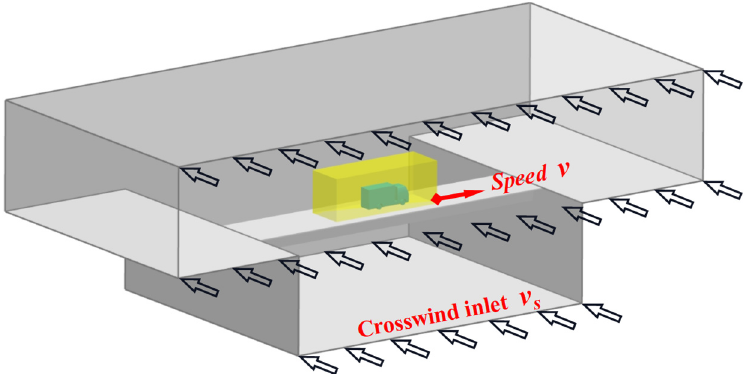
Figure 3. Analysis method for a vehicle on the bridge: the black arrows represent the direction of the crosswind and the direction is perpendicular to the crosswind inlet surface.